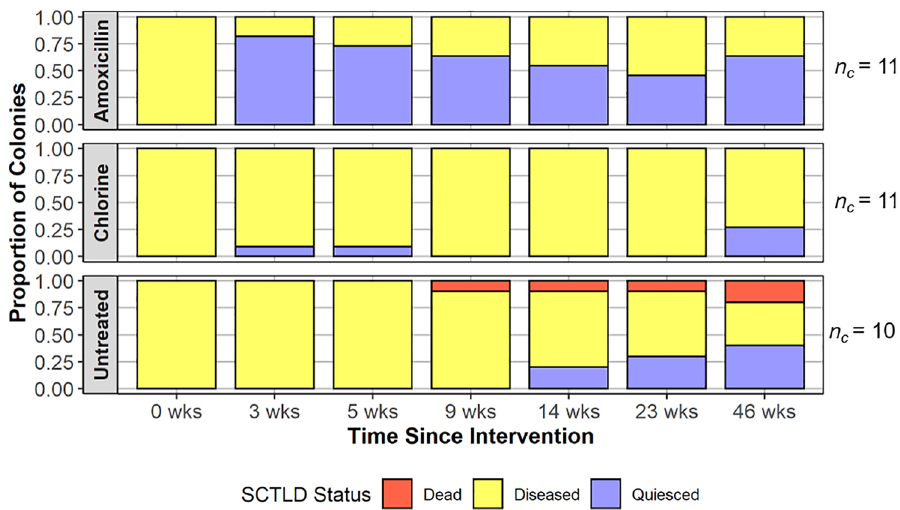
Figure 5. Disease status of colonies by treatment group at each time point shown in proportions of total, with n c representing the total number of colonies in the treatment group. Amoxicillin refers to the Base 2B plus amoxicillin treatment, chlorine refers to the chlorinated epoxy treatment, and untreated refers to the SCTLD- affected controls.